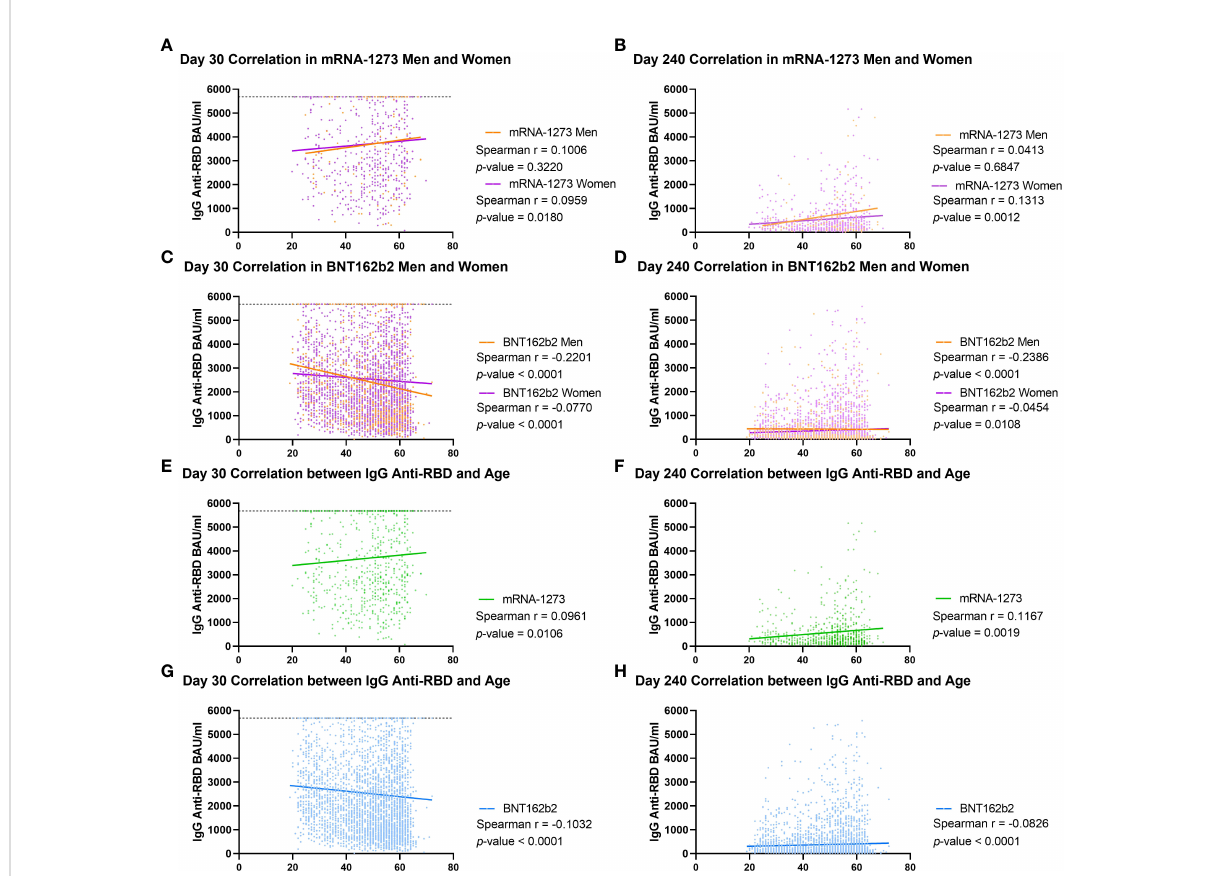
FIGURE 3 Correlation between IgG anti-RBD levels and age in cohorts strati fi ed by type of vaccine and gender. Spearman correlation was calculated for male and female volunteers vaccinated with mRNA-1273 on day 30 (A) and 240 (B) and for men and women vaccinated with BNT162b2 on day 30 (C) and 240 (D) . This analysis was performed in all volunteers, regardless of gender, vaccinated with mRNA-1273 on day 30 (E) and day 240 (F) or with BNT162b2 [day 30 (G) , and day 240 (H) ]. IgG anti-RBD levels were calculated as in international units (BAU/ml). Each dot indicates an individual value, and the lines indicate linear regression. On day 30, the dotted line at 5,680 BAU/ml indicates the higher limit of quanti fi cation. The Spearman r and p -value are indicated for each group. p -values < 0.05 were considered signi fi